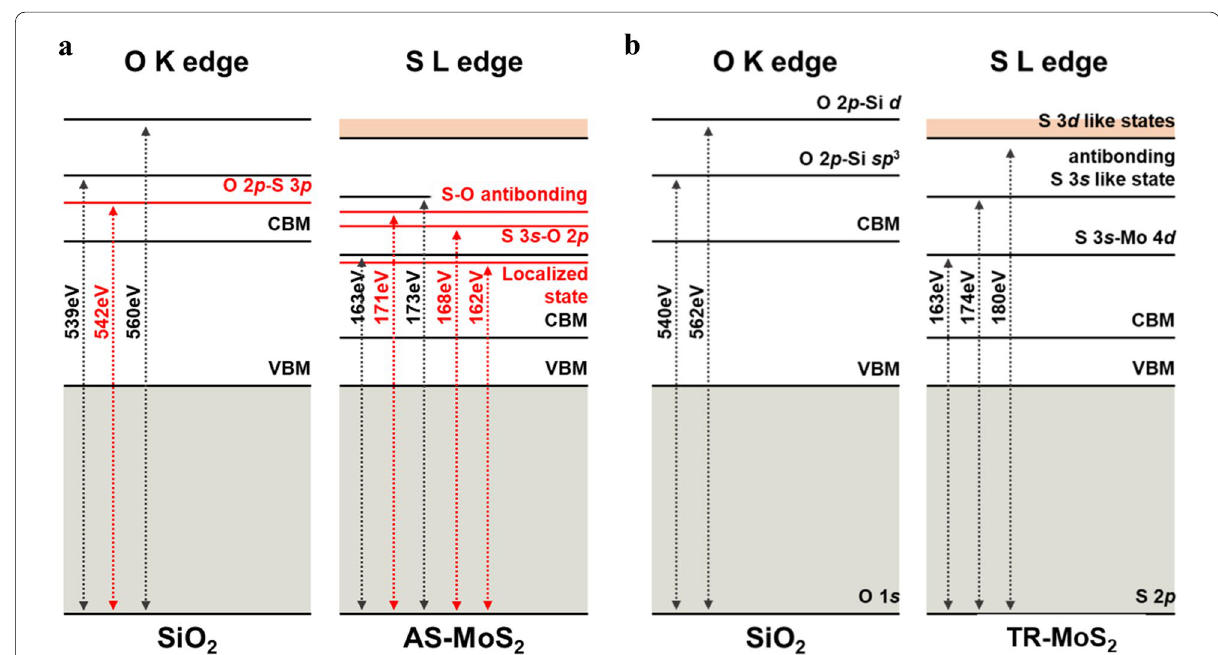
Fig. 5 Electron transition diagram of the SiO 2 layer a at the AS-MoS 2 /SiO 2 and b TR-MoS 2 /SiO 2